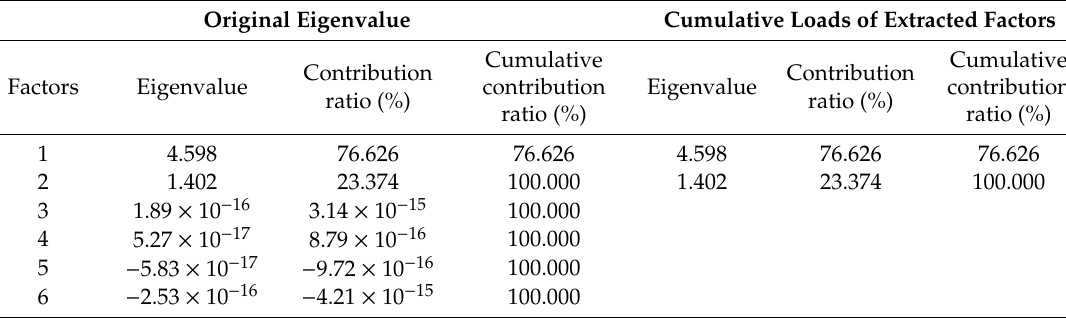
Table 6. The eigenvalue and contribution ratios for principal components.